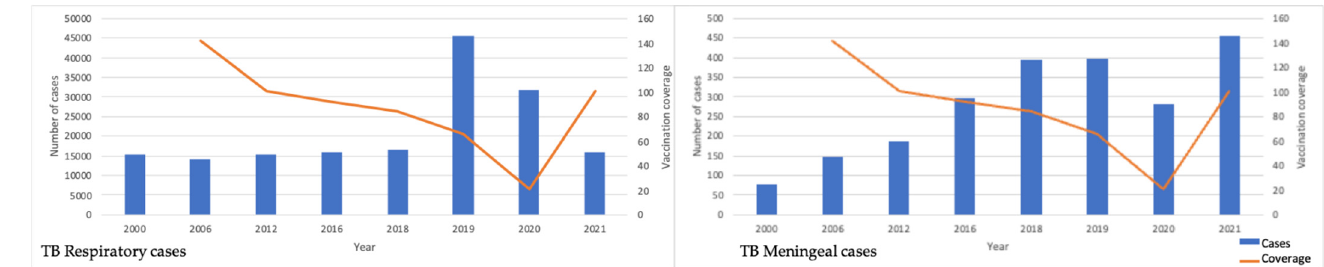
Figure 4. Number of newly reported cases of respiratory and meningeal tuberculosis compared to vaccine coverage.